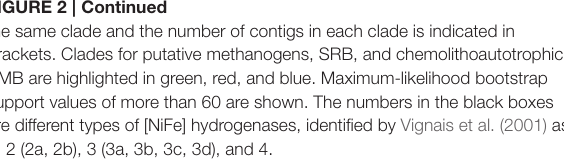
(Table S3: 0.363 and 0.034). The latter included Sulfurovum ,